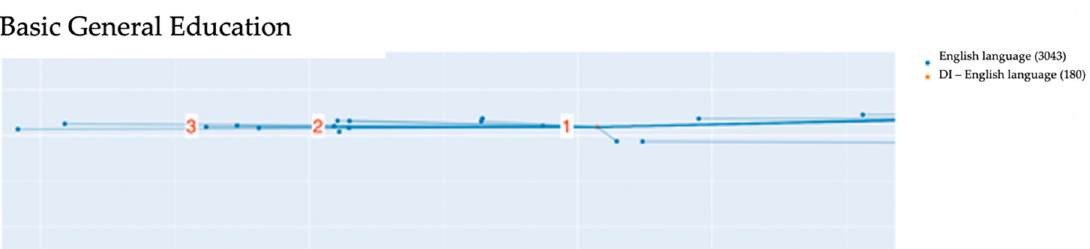
Figure 8. Semantic cluster “Healthy Lifestyle” Distance between objects.